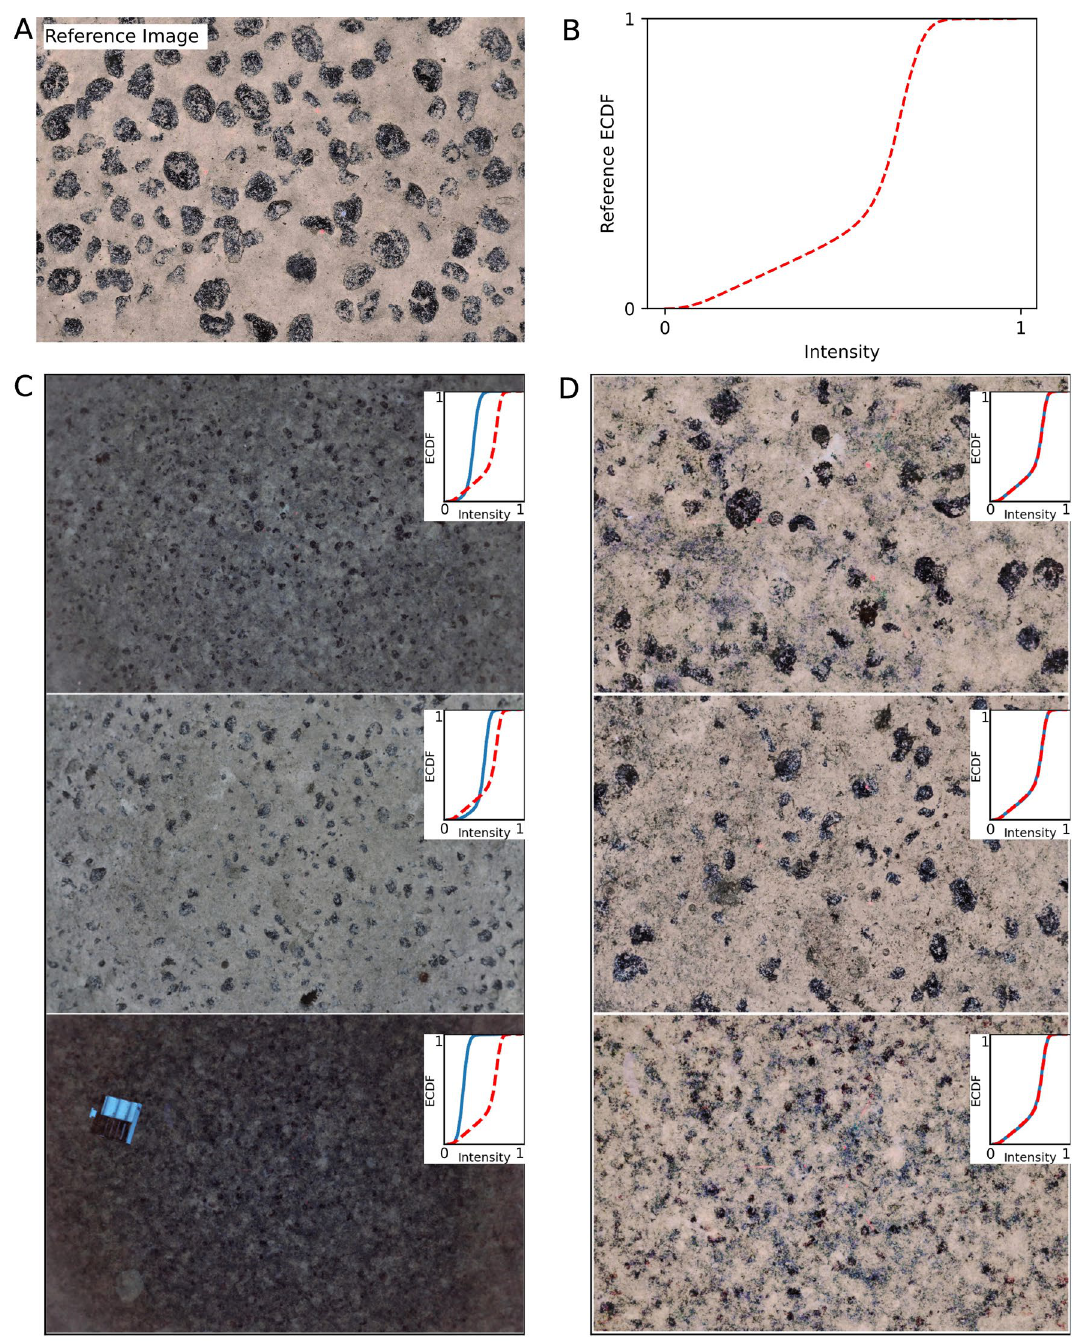
Figure 4. ( A ) Reference image used for color normalization and, ( B ) The Empirical Cumulative Distribution Function for the reference image. ( C ) Comparison between adaptive histogram equalized images and, ( D ) color normalized and rescaled center cropped